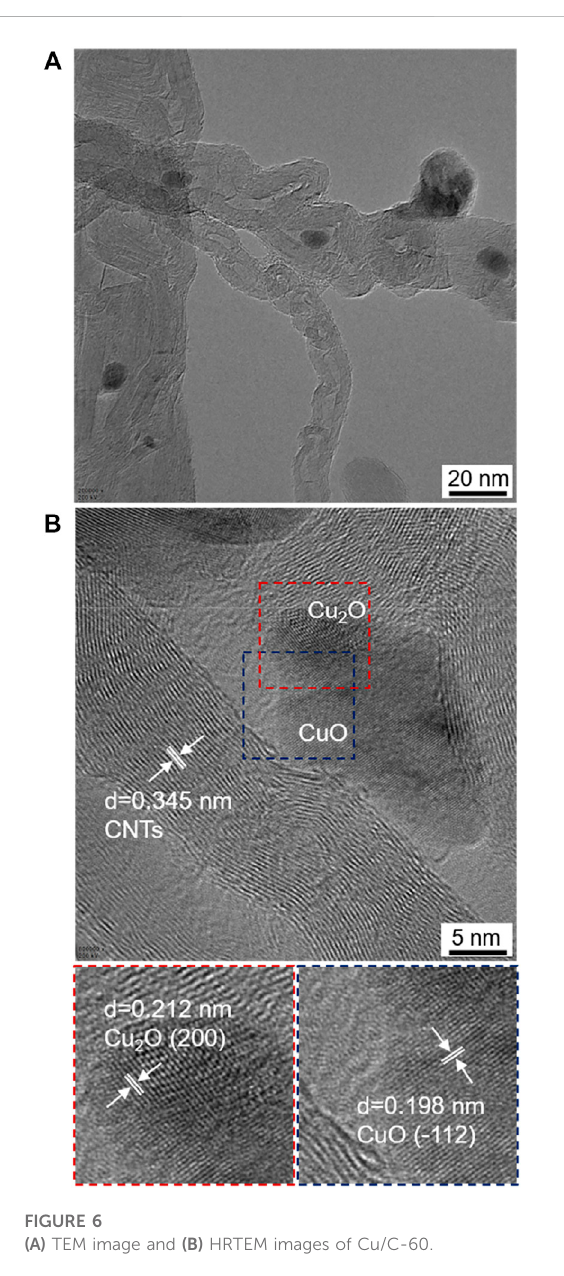
FIGURE 6 (A) TEM image and (B) HRTEM images of